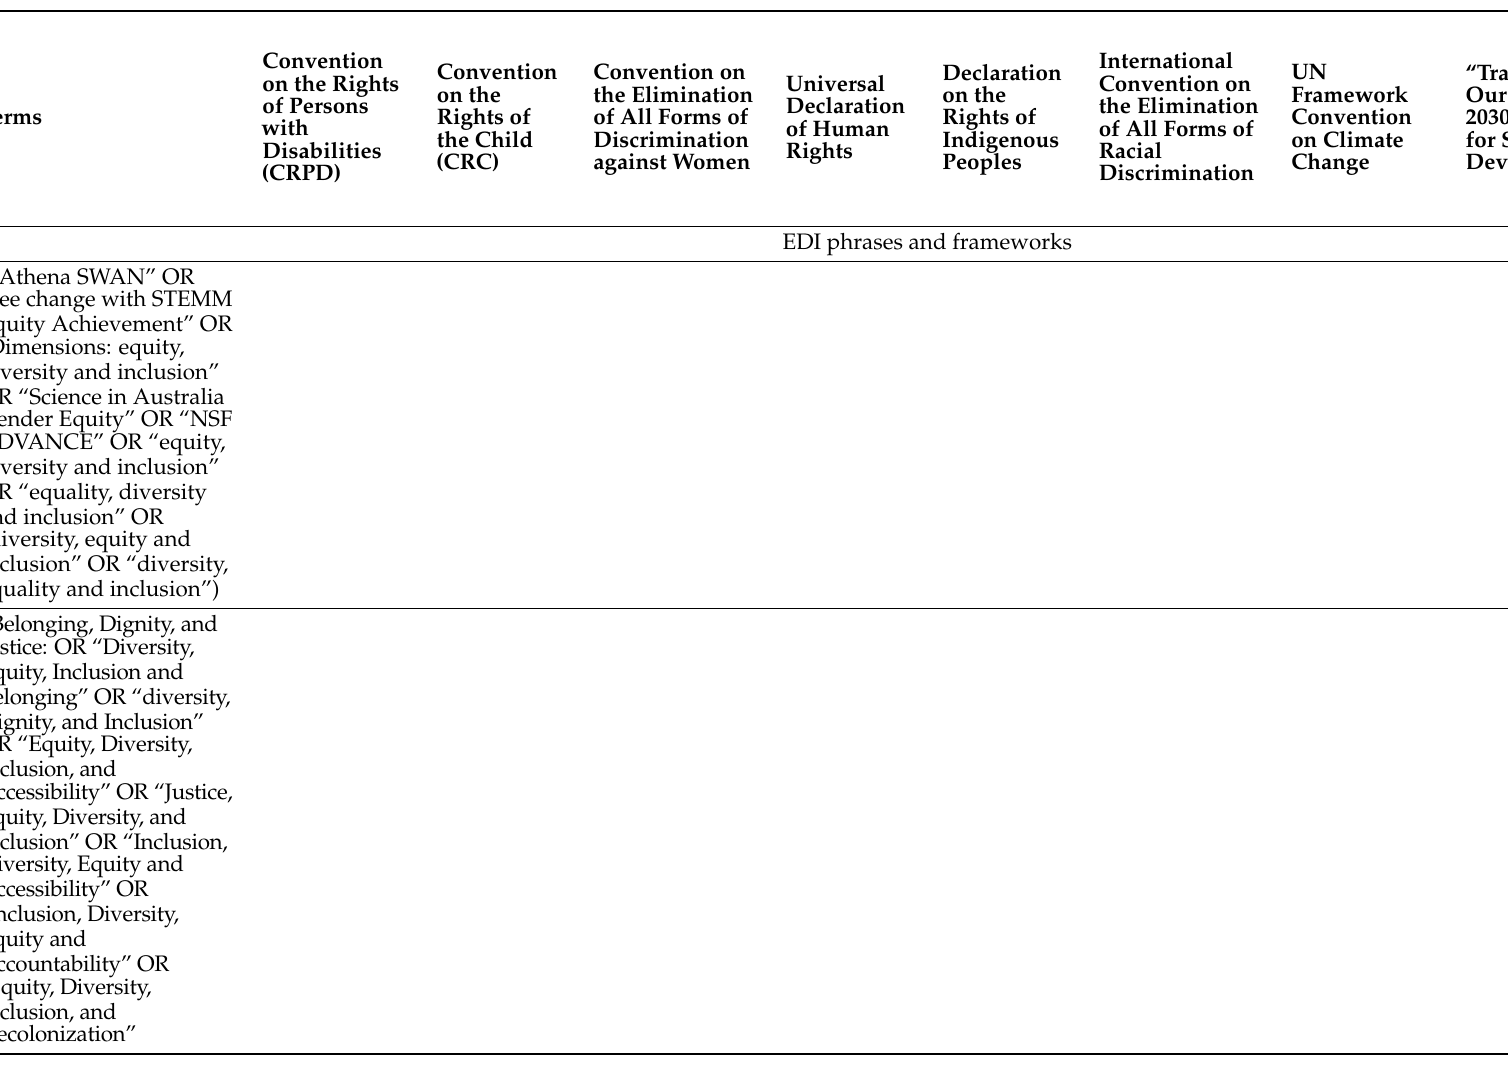
Table 17. Presence of EDI phrases and frameworks and marginalized groups covered within EDI in the actual document such as the